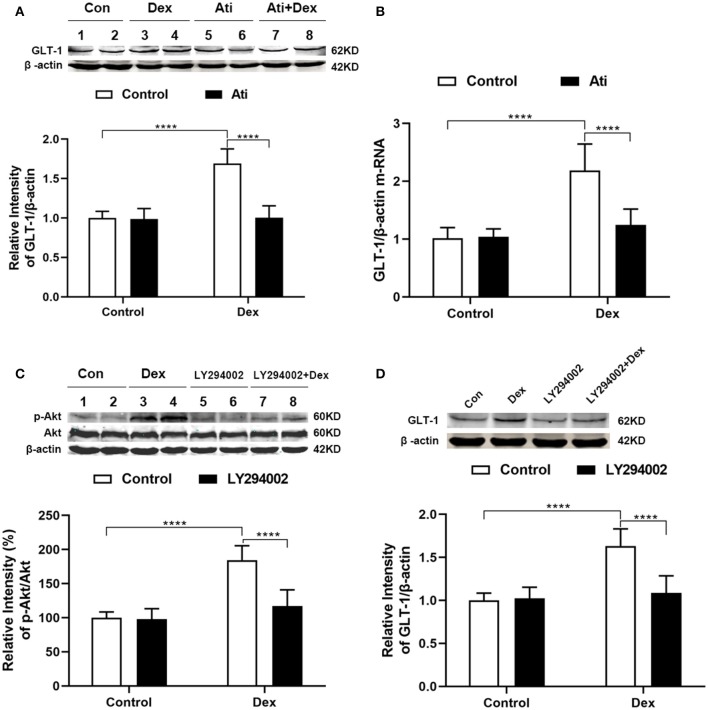
Atipamezole and LY294002 reversed the upregulation of GLT-1 induced by dexmedetomidine. Cultured astrocytes were harvested after drugs administration (Dex, 100 nM, 30 min; Atipamezole, 300 nM, 1 h). (A,B) Western blot and RT-PCR showed that the upregulation of GLT-1 induced by dexmedetomidine dramatically reversed by Atipamezole (t = 11.84, p < 0.0001) (t = 7.965, p < 0.0001), respectively, while Atipamezole did not affect the GLT-1 protein and mRNA itself. (C,D) Western blotting showed that LY294002 reversed the upregulation of p-Akt/Akt (t = 9.088, p < 0.0001) and GLT-1 (t = 8.335, p < 0.0001) induced by dexmedetomidine. Data are expressed as mean ± SD (n sample = 12 cell wells per group, 3 independent cell preparations were performed). ****p < 0.0001 (two-way ANOVA followed by the Bonferroni multiple comparisons test).